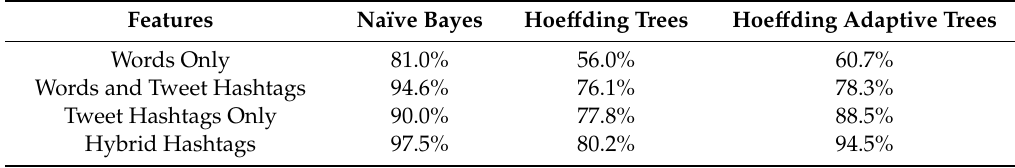
Table 6. Comparison of HHTC Tweet topic classification results with di ff erent set of features.